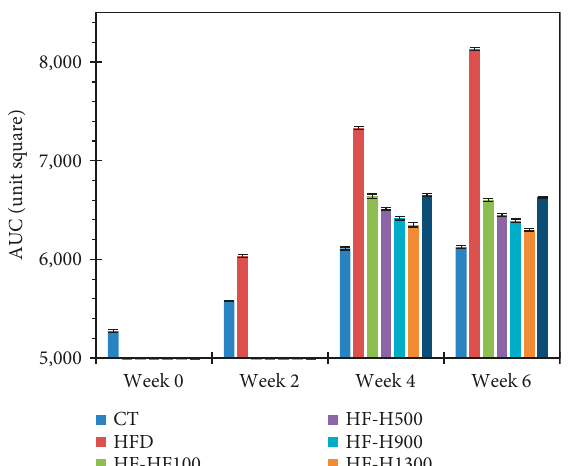
Figure 4: The area under curve (AUC) of PBL after feeding of glucose (data were shown in mean ± standard deviation, n � 5).